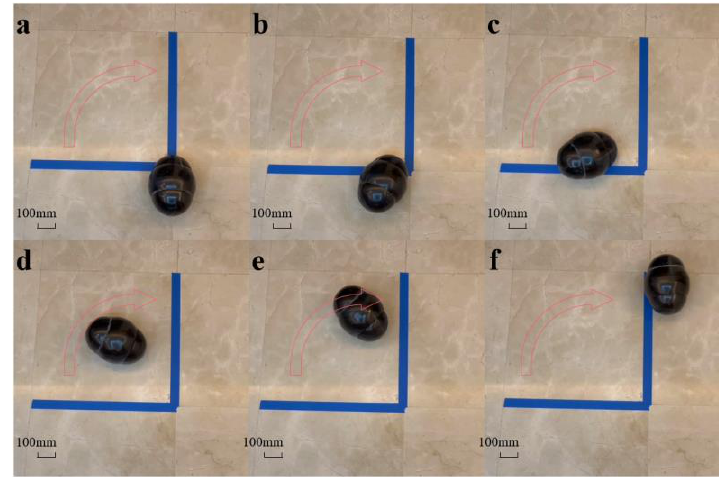
Figure 17. Turning motion of the robot.